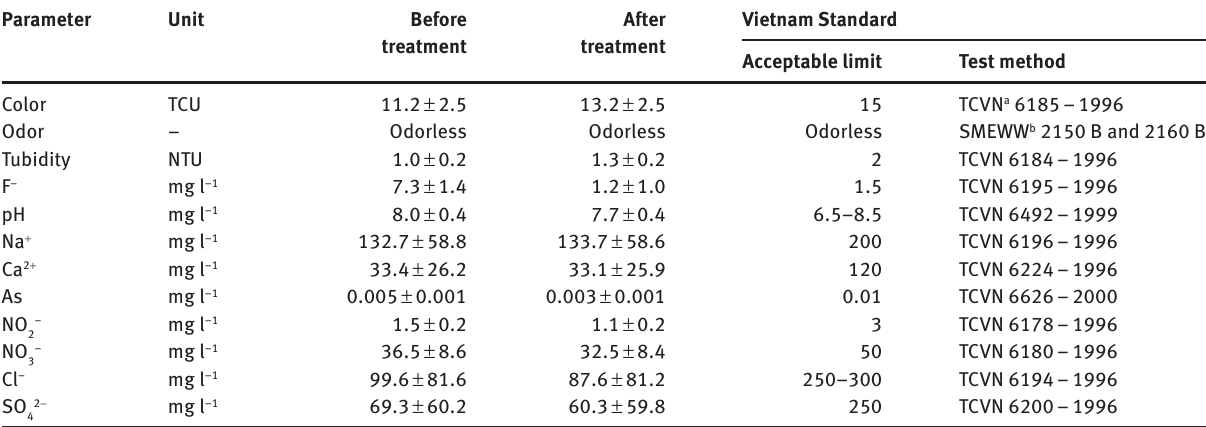
Table 9: Water quality parameters of well-water samples at Ninhthuong commune.